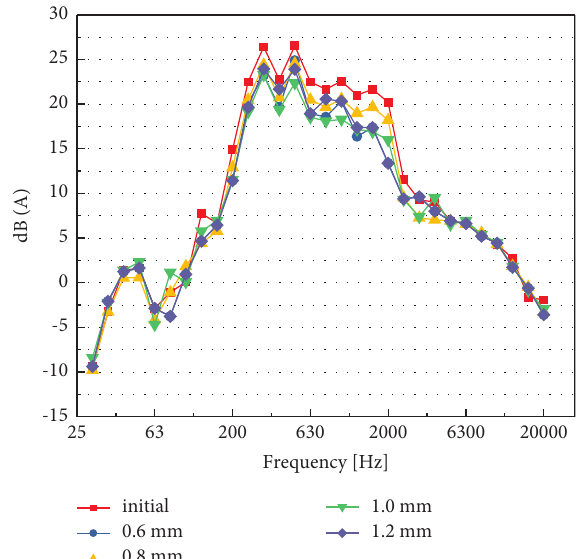
Figure 9: Frequency domain diagram of noise distribution equipped with different sizes of aeration devices.